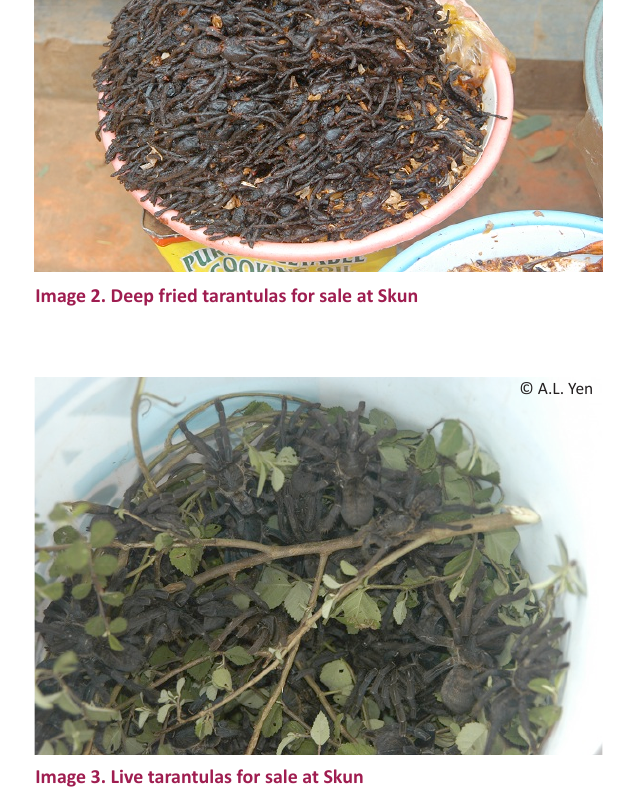
Image 3. Live tarantulas for sale at Skun